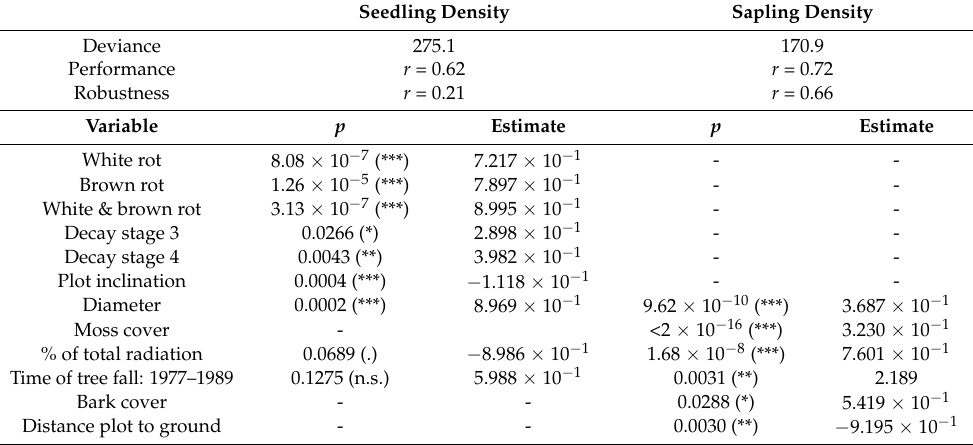
Table 2. Deviance, performance, robustness, and significance of the different variables used in the final model for the seedling (recently germinated plants with the characteristic four to nine cotyledons) and sapling (height > 10 cm) density on the